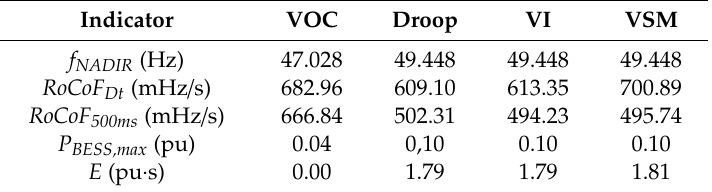
Table 5. Summary of main systems’ performance